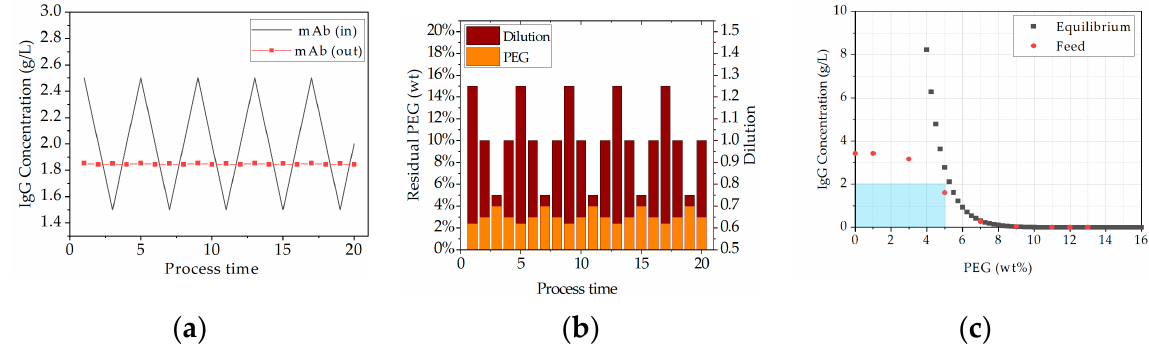
Figure 22. Second simulation study results of scenario one (concentration fluctuations). ( a ) shows the comparison of incoming concentration and the adjusted IgG concentration after dissolution because of the integrated APC. ( b ) shows the parameter that must be controlled to achieve the constant output concentration of 2 g/L and ( c ) depicts the equilibrium concentration of IgG in presence of PEG. The blue zone in ( c ) marks the operating window of residual PEG content.